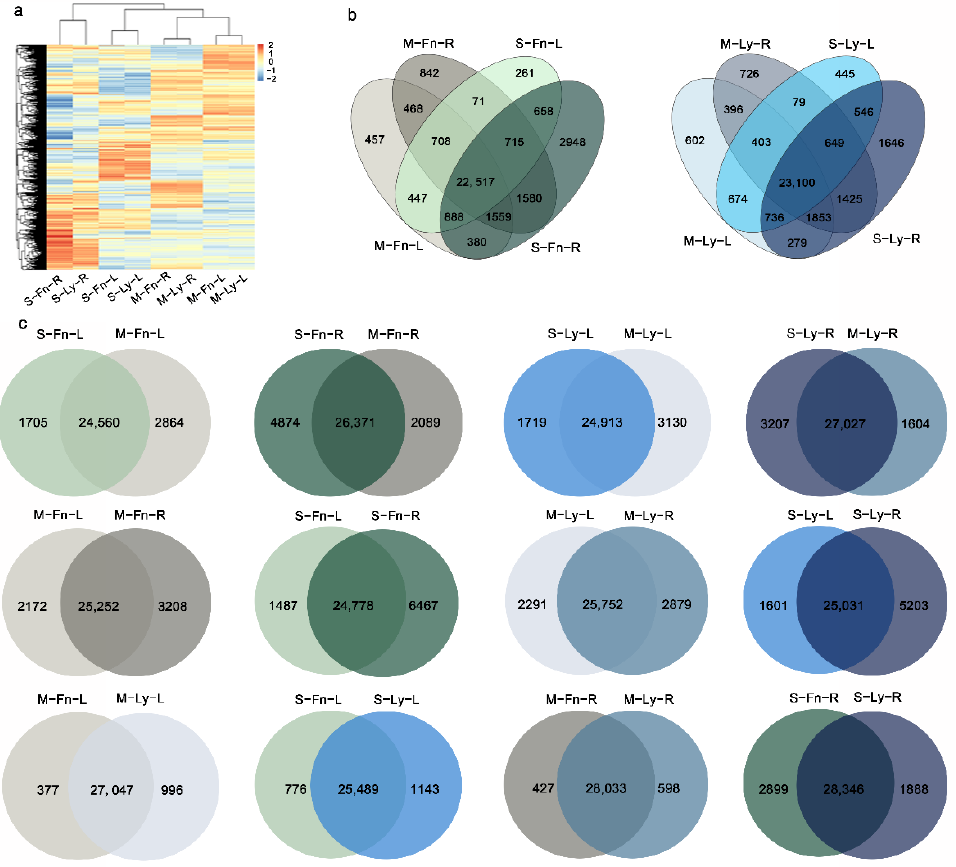
Figure 3. ( a ) Genome-wide gene expression between root and leaf in Fanni and Longya10 under mock or saline stress. Yellow indicates gene expression levels (read counts per million with log2 value). ( b , c ) Venn diagram of common and specific gene expression in Fanni and Longya10 under 100 mM NaCl solution. M −Fn−R and M −Ly−R represent the root samples derived from Fanni and Longya10 plants, respectively. S −Fn−R and S −Ly−R represent the saline-stress-treated root samples derived from Fanni and Longya10 plants, respectively . M−Fn−L and M−Ly−L represent the leaf sam- ples derived from Fanni and Longya10 plants, respectively. S−Fn−L and S−Ly−L represent the sa- line-stress-treated leaf samples derived from Fanni and Longya10 plants, respectively.